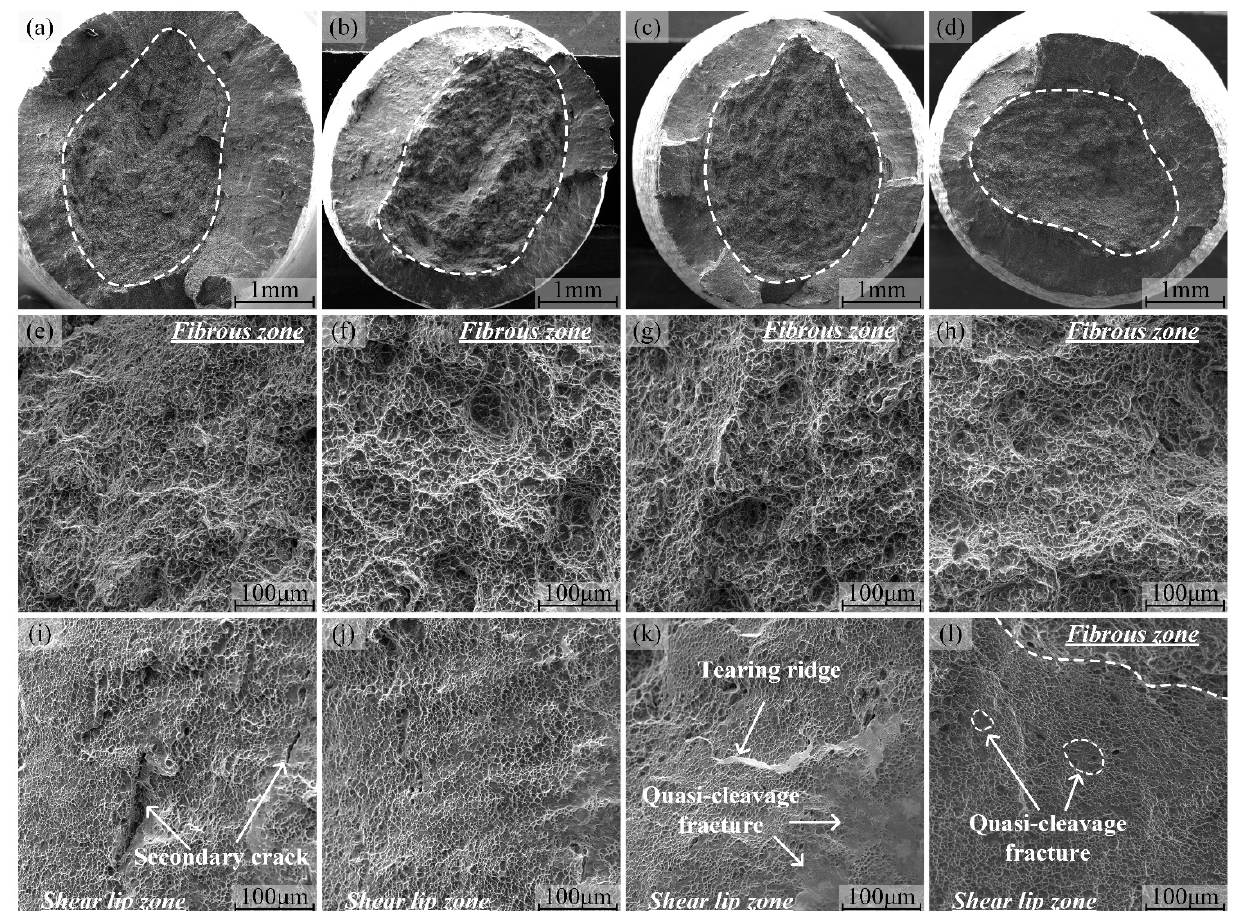
Figure 5. Fracture morphology: ( a ) 20 °C, ( b ) 100 °C, ( c ) 150 °C, ( d ) 200 °C; fibrous zone: ( e ) 20 °C, ( f ) 100 °C, ( g ) 150 °C, ( h ) 200 °C; shear lip zone: ( i ) 20 °C, ( j ) 100 °C, ( k ) 150 °C, ( l ) 200 °C.